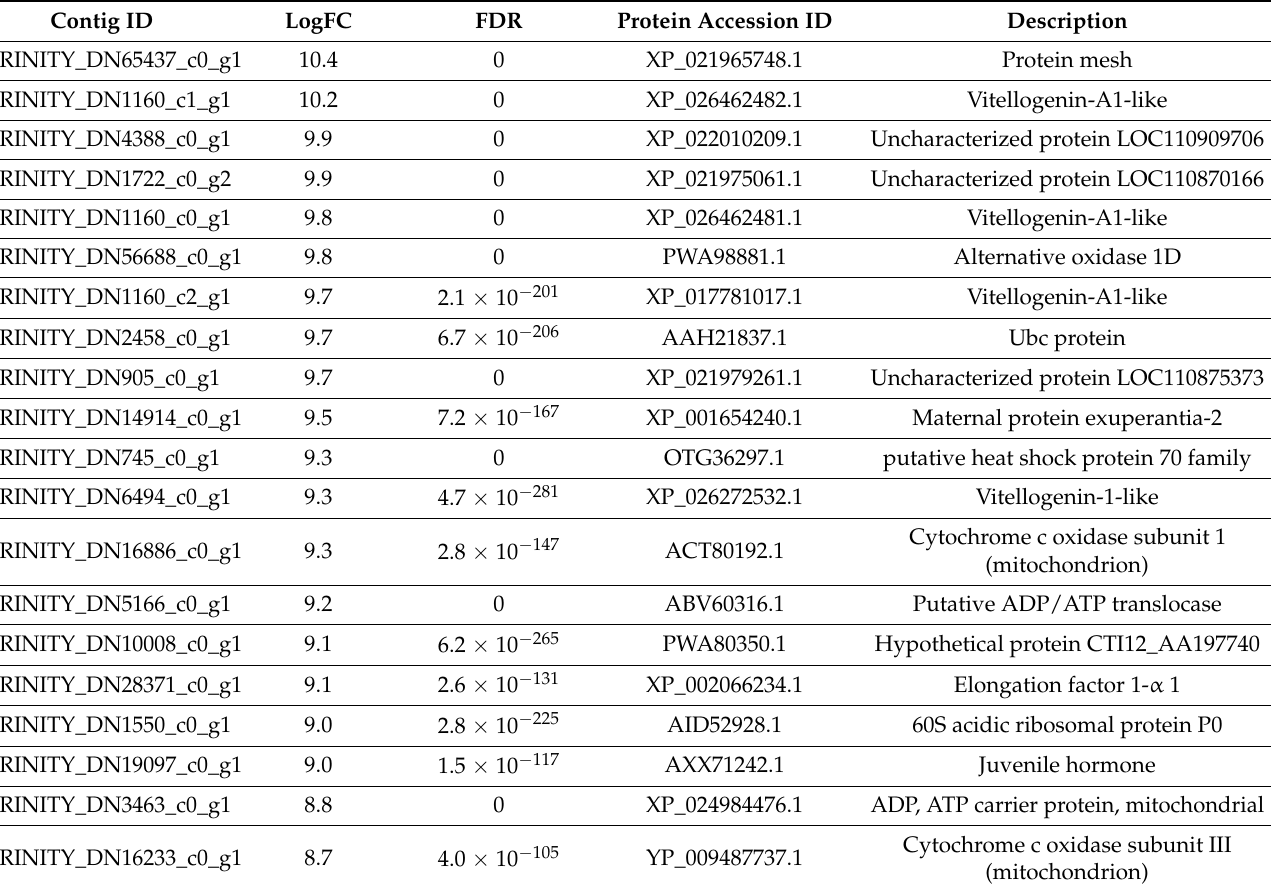
Table 4. The gene list of the top 20 upregulated genes in TNSG vs. TNSC. De novo transcriptome analysis was performed by Trinity with 13 libraires (5 glyphosate-treated and 8 non-treated leaves). EdgeR was used for DEG analysis. A total of 3715 genes were upregulated (FC > 4) in TNSG than TNSC (FDR < 0.05). The top 20 genes are listed in this